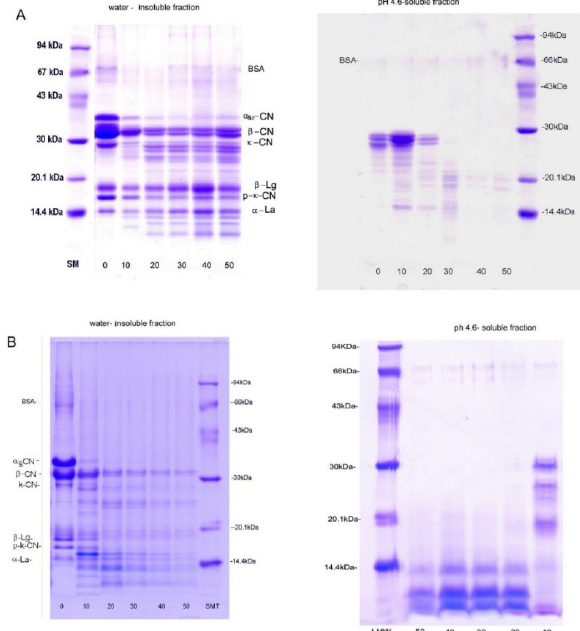
Figure 1. Sodium dodecyl sulfate polyacrylamide gel electrophoresis (SDS-PAGE) analysis of water-insoluble, and pH 4.6 soluble nitrogen fraction of experimental goat ( A ) and cow’s milk ( B ) cheeses *. * 0–50 days of ripening; SM: molecular weight standards.